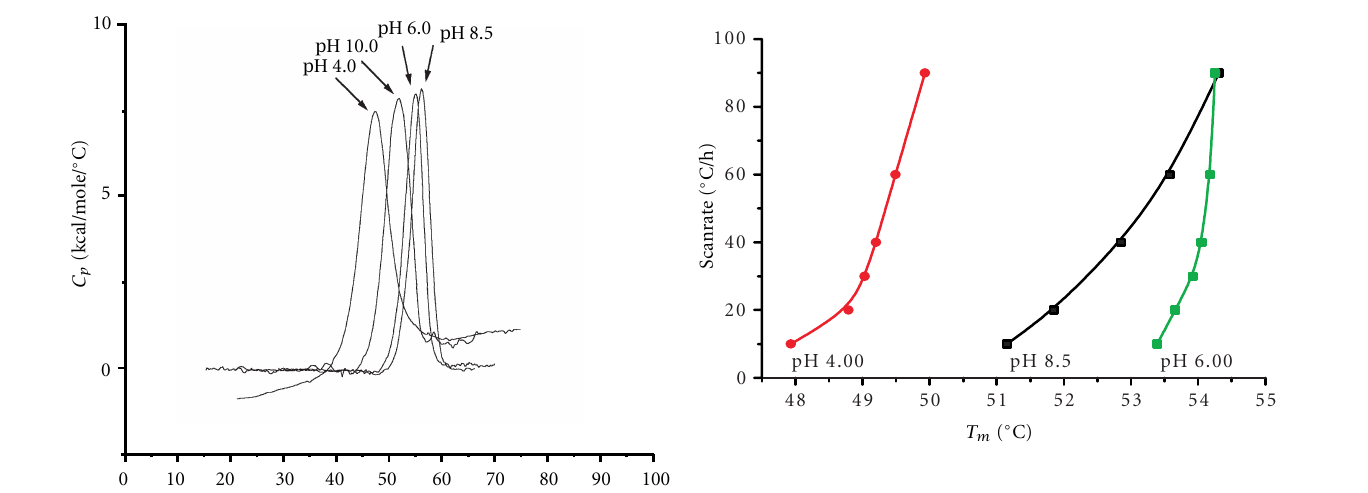
Figure 3: Scanrate dependence of T m at different pH values. Scan- rate dependence of cutinase at pH 4 . 00 , 6 . 00 , and 8 . 5 . The scans were performed in three different buffers. The scanrates varied from 90 to 10 ◦ C/h. From the dependence of T m on the scanrate the rate constant for the unfolding can be determined.